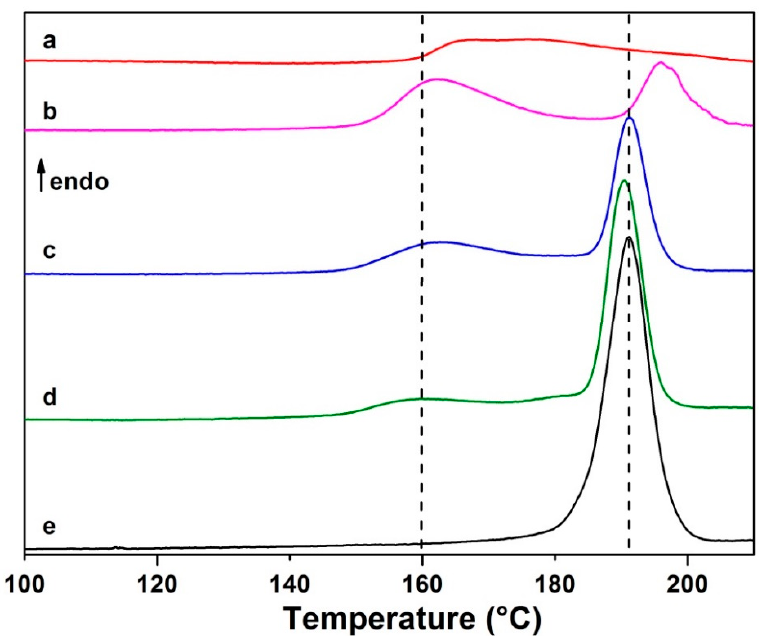
Figure 3. DSC analysis up to 210 °C at 5 °C/min, under 2 bar of H 2 , of (a) Ca(BH 4 ) 2 , (b) 1Mg(BH 4 ) 2 : 2Ca(BH 4 ) 2 , (c) 1Mg(BH 4 ) 2 : 1Ca(BH 4 ) 2 , (d) 2Mg(BH 4 ) 2 : 1Ca(BH 4 ) 2 , and (e) Mg(BH 4 ) 2 after ball milling. Only the first heating ramp is reported.